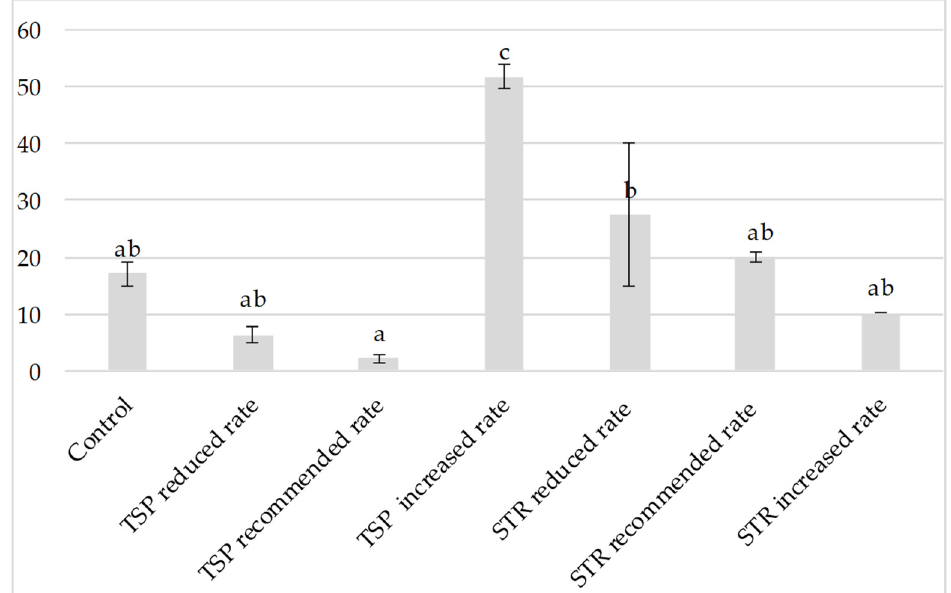
Figure 4. Magnesium uptake by butterhead lettuce leaves (mg per leaves mass) as affected by the interaction of examined factors (A × B) at the level of significance α = 0.05 ( p value < 0.001).